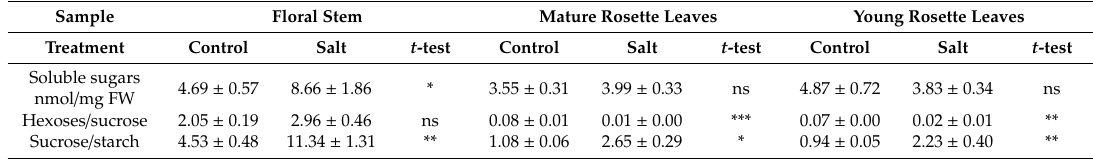
Table 1. Comparison of sugar and starch contents in the rosette and leaves in response to salt stress. Sample Floral Stem Mature Rosette Leaves Young Rosette Leaves Treatment Control Salt t -test Control Salt t -test Control Salt t -test Soluble sugars 4.69 ± 0.57 nmol/mg FW Hexoses/sucrose